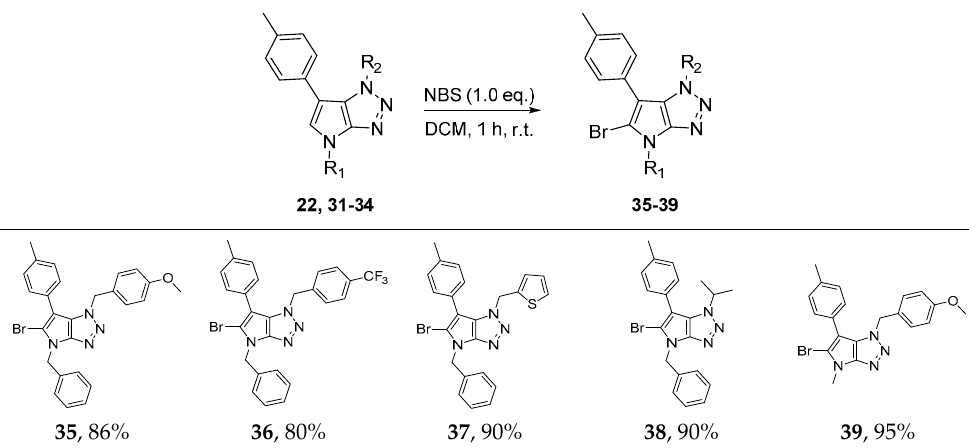
Table 7. Scope of the Suzuki-Miyaura reaction in C-5 position: s ynthesis of 40 – 53 a .